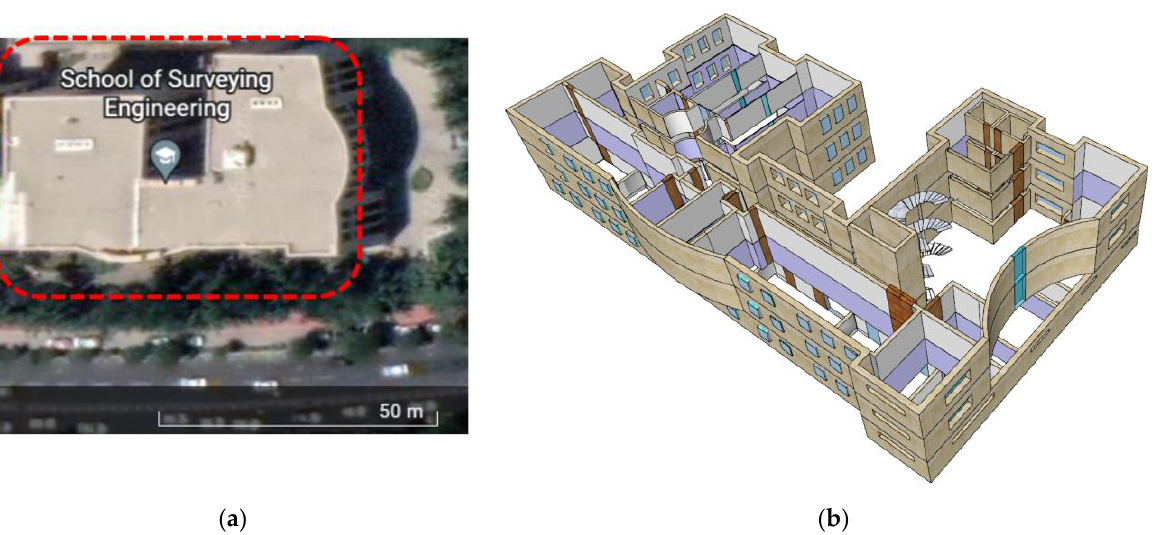
Figure 15. The case study area; ( a ) the area on the google map; ( b ) The interior environment of the area.